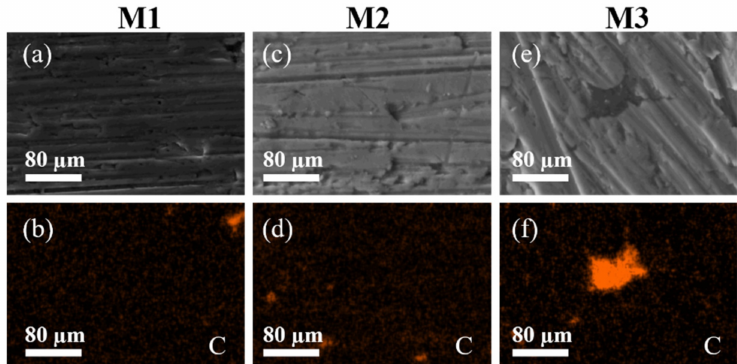
Figure 3. BSE-SEM micrographs ( a , c , e ) confirm that the MWCNTs are mainly located in the sur- rounding of the Al grains creating a CNT network within the SPS material samples. Images ( b , d , f ) are the samples M1, M2 and M3 energy dispersive spectroscopy (EDS) elemental mapping. The MWCNT distribution is similar in all sintered samples. Image ( f ) shows a cluster of MWCNT.